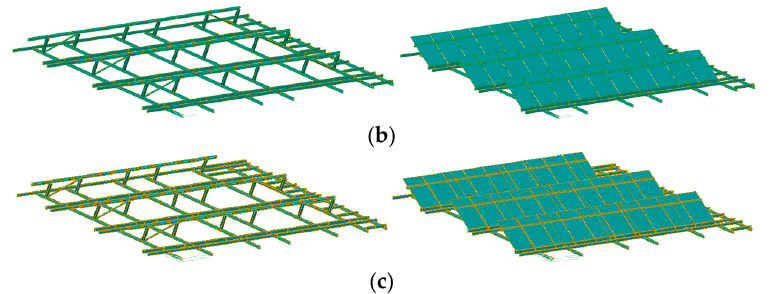
Figure 5. Finite element (FE) analysis model; ( a ) A type; ( b ) B type; ( c ) C type.